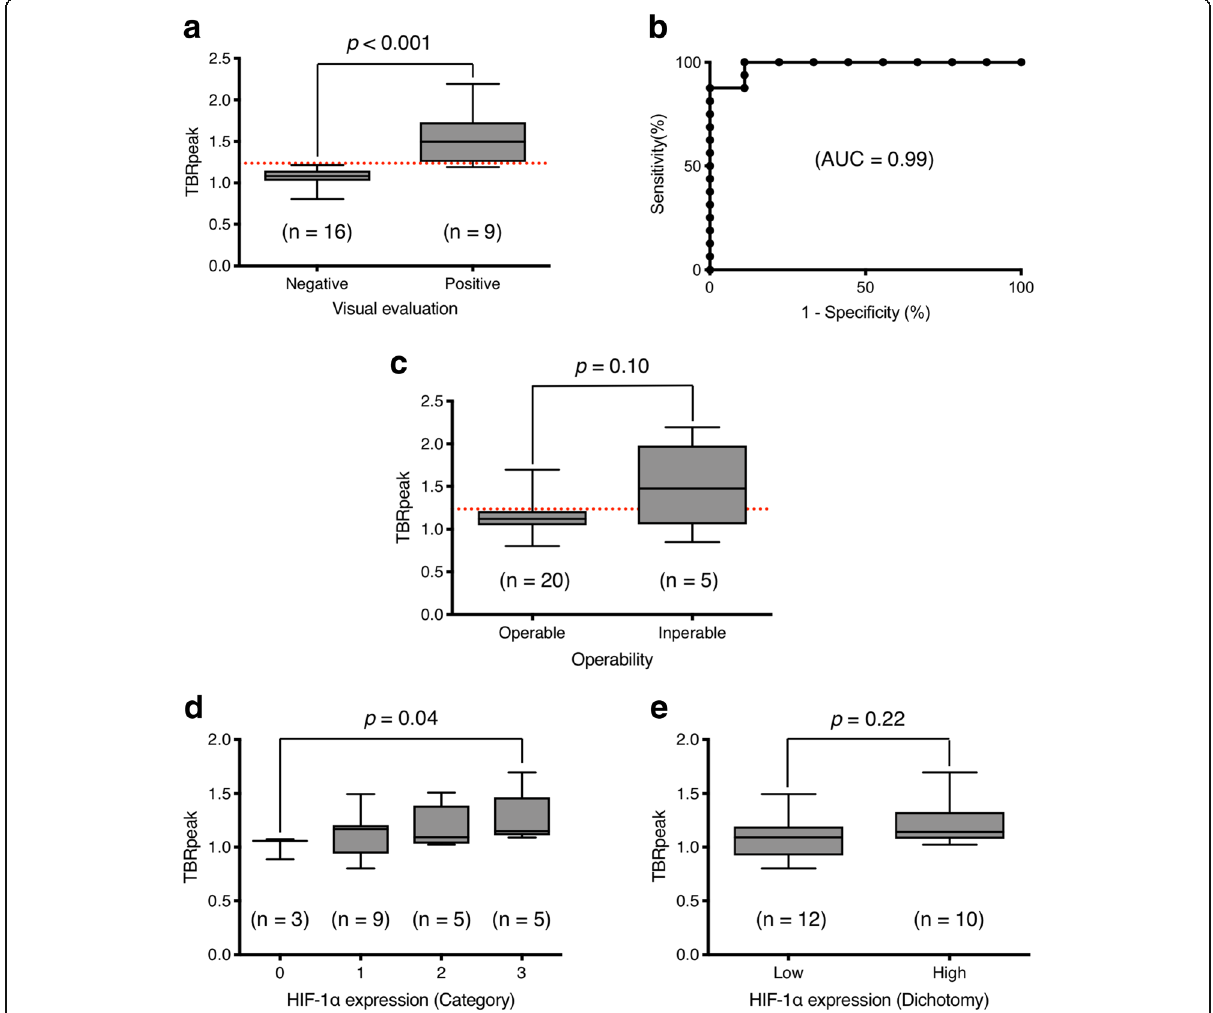
Fig. 1 Box plots of TBRpeak by the results of visual evaluation of [ 18 F]FMISO PET/CT ( a ), TBRpeak of operable and inoperable patients ( c ), TBRpeak by HIF-1 α immunohistochemical expressions evaluated by 4 categories (0, 1, 2, and 3) ( d ), and 2 categories (low and high) ( e ). Red horizontal dot lines indicate TBRpeak = 1.24 calculated by the receiver operating characteristic analysis ( b ). Lines on whiskers and boxes in box blots indicate maximum, upper quartile, median, lower quartile, and minimum,